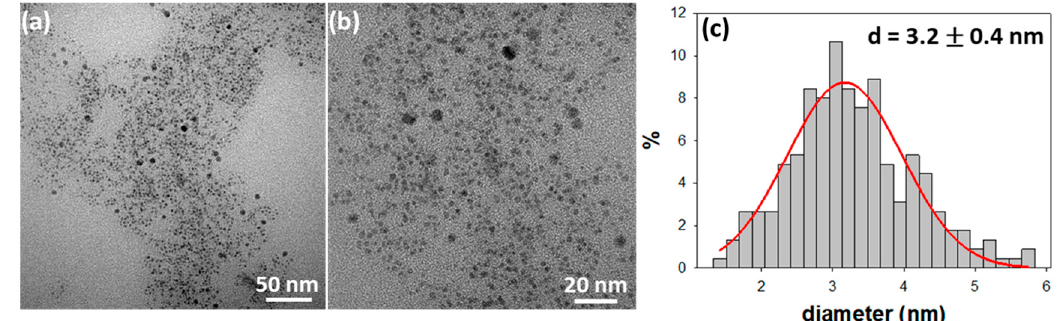
Figure 1. TEM images ( a , b ) and size distribution histogram ( c ) of the electrosynthesized copper nanoparticles (CuNPs) stabilized by benzalkonium chloride (BAC)(CuNPs@BAC) (0.1 M, 1.5 V). The mean NP core diameter is reported in the inset, along with the relevant standard deviation (n = 225).